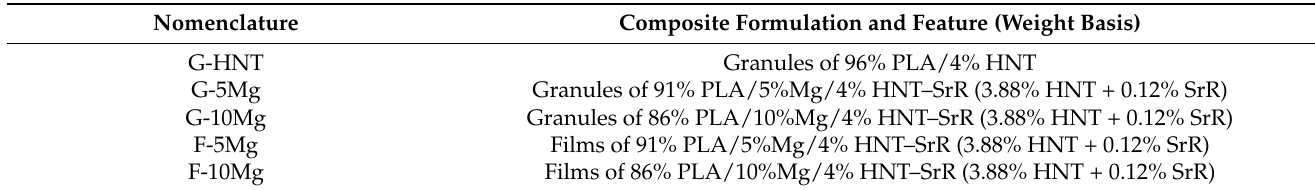
Table 1. Summary of the formulated